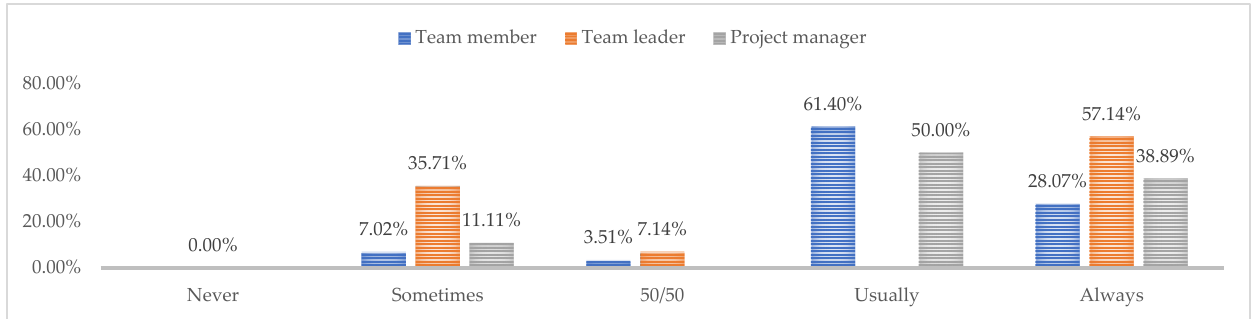
Figure 3. Risk management during project implementation (n = 89).